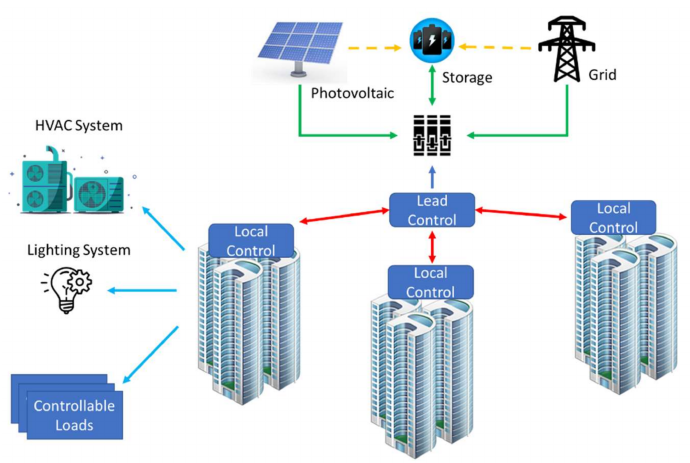
Figure 3. Illustration of the decentralized BEMS approach.